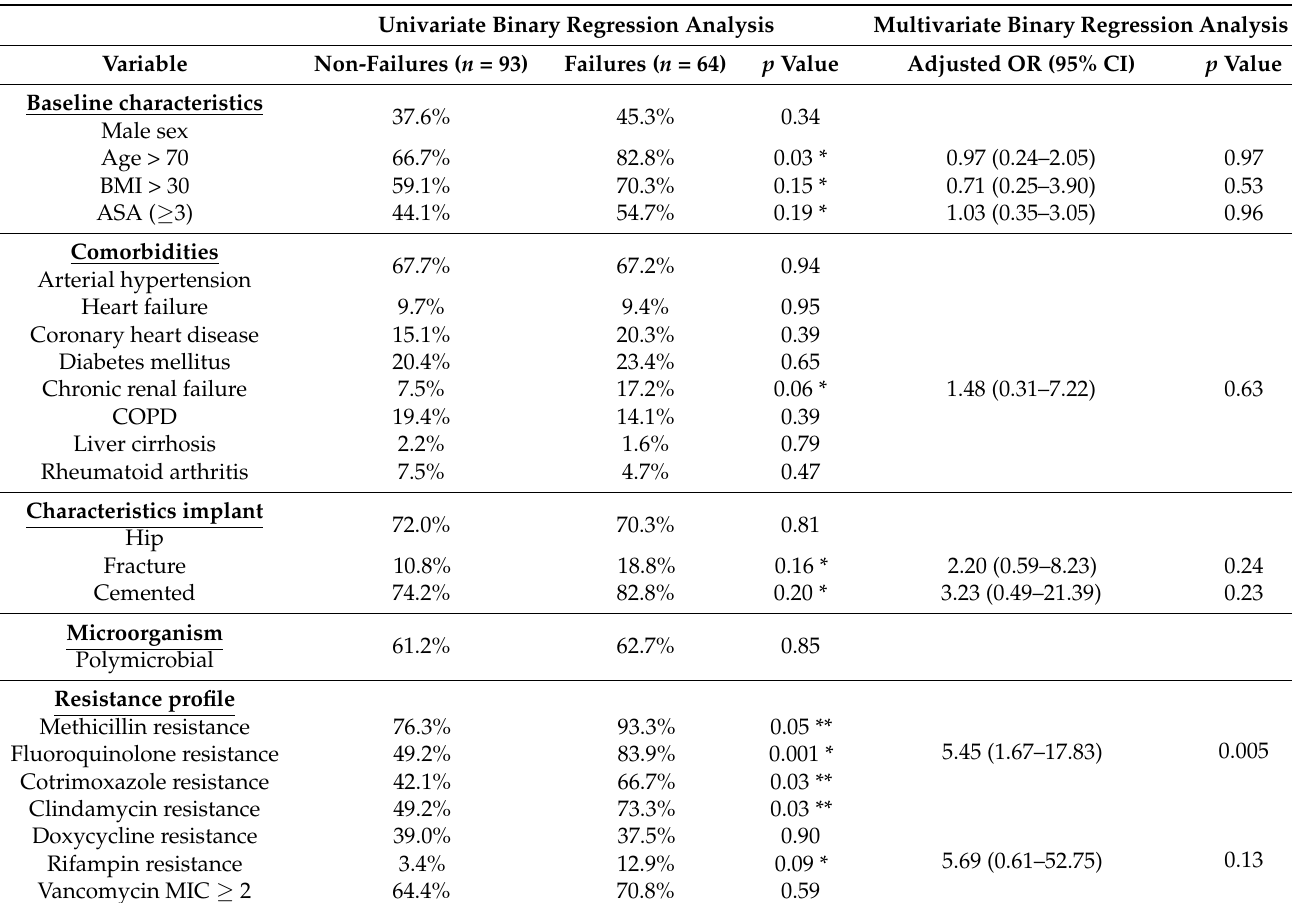
Table 1. Risk factors for clinical failure in patients with early PJI caused by S. epidermidis . Univariate Binary Regression Analysis Multivariate Binary Regression